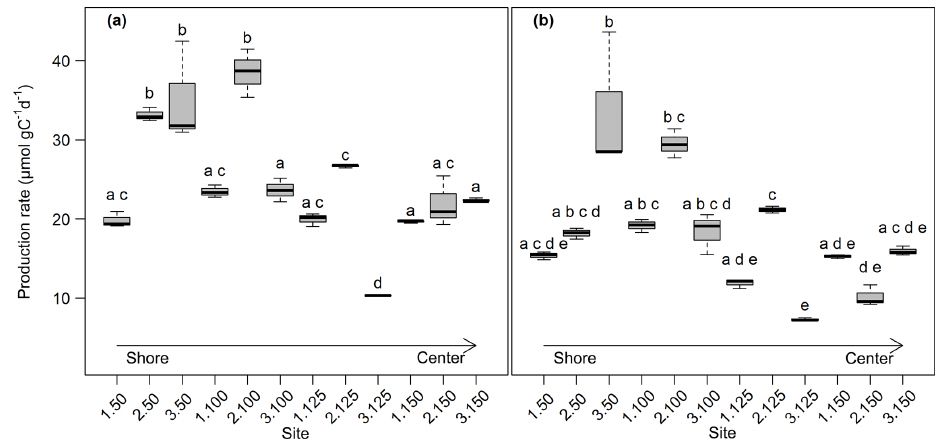
Figure 3. CO 2 (a) and CH 4 (b) production rates at 0–5cm sediment depth ( n = 3). Production rates were calculated from the linear regression of concentration increase over time. Bold lines are the median, boxes show the 25 and 75 percentile, and whiskers indicate minima and maxima within 1.5 times the interquartile range. Identical lowercase letters indicate production rates that were not significantly different (i.e., p> 0 . 05) from each other.